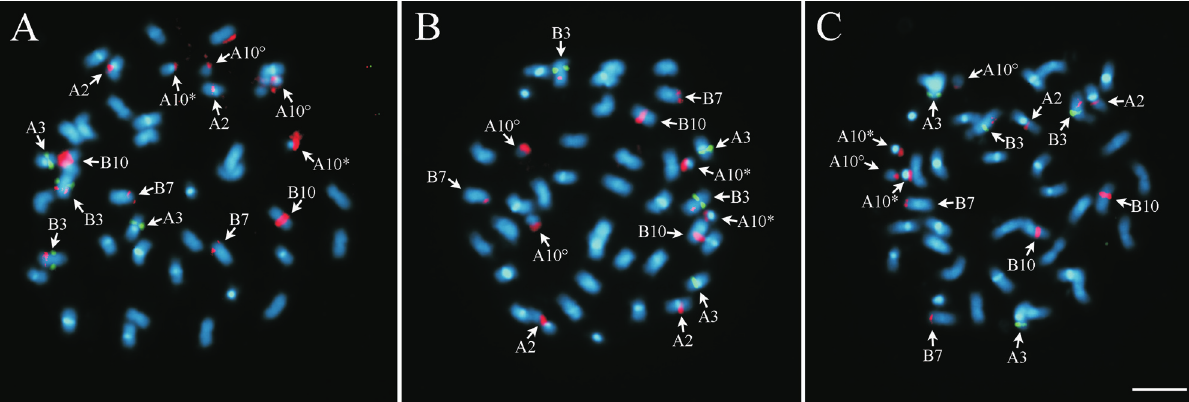
Figure 5 - FISH using 5S (green) and 45S (red) rDNA probes, followed by DAPI counterstaining (blue). A) Xingu type Of 126; B) A. hypogaea ‘IAC Tatu-ST’ and C) A. monticola V 14165 . Chromosome B3 shows 5S and 45S rDNA signals co-localized. A10 with secondary constriction, short arm and proximal segment of the long arm (*) and the satellite (°). Bar: 5 (cid:2)